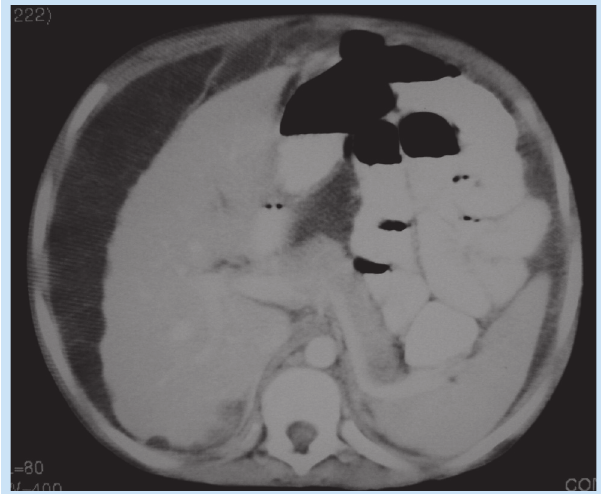
Fig.2c. Axial contrasted CT scan of the abdomen shows intraperitoneal spillage with multiple small cysts compressing the liver and resulting in a scalloped